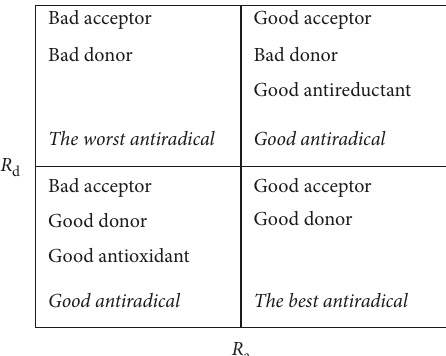
Figure 1: Schematic representation of donor-acceptor map